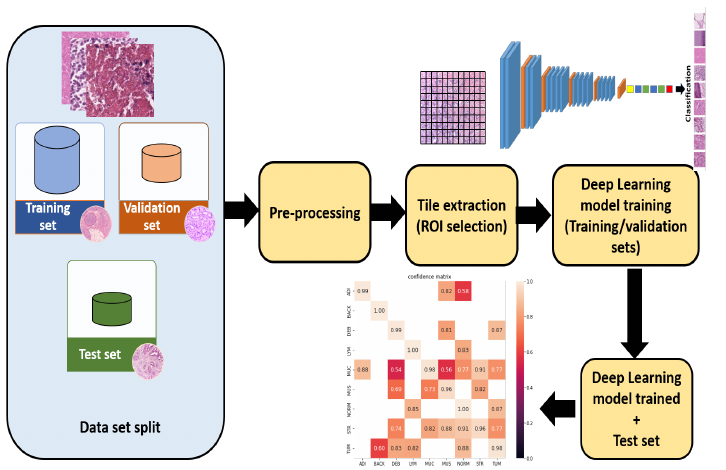
Figure 3. Block diagram for pathology WSI classification with VGG19 deep learning model, in a multi-class